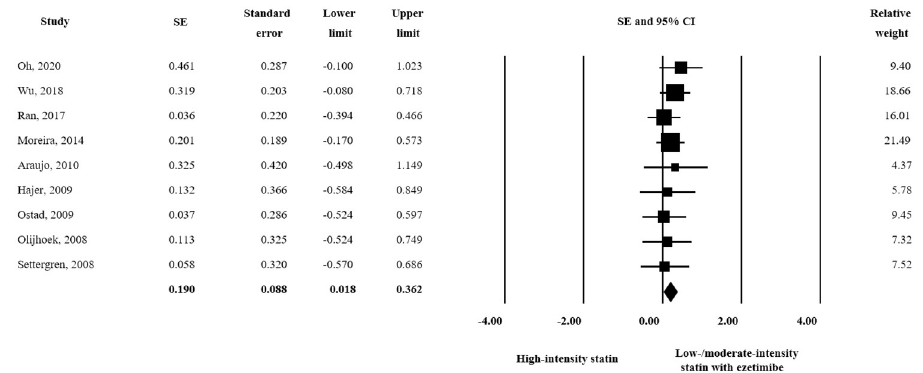
Fig 6. Forest plot of efficacy evaluation results. Changes in hs-CRP observed for high-intensity statin monotherapy and low/moderate-intensity statin plus ezetimibe combination therapy.